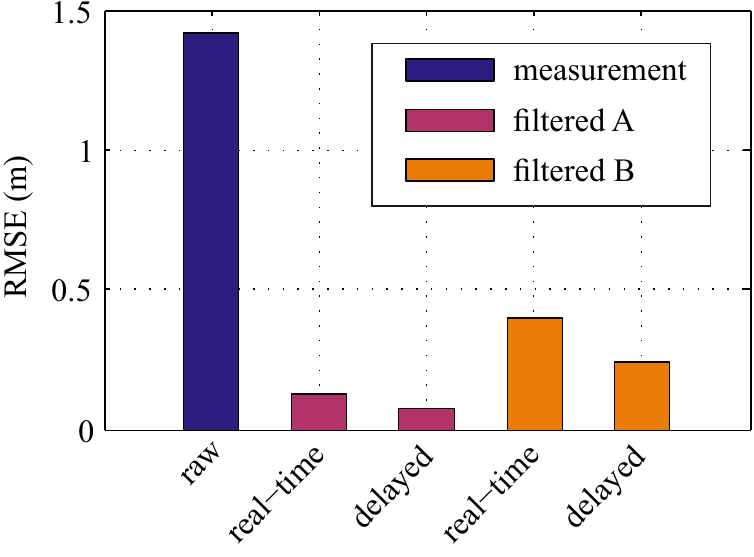
Figure 7. RMSE for filtering real data. The RMSE with respect to the RTK-GPS reference data adds up to 1.42 m for the raw measurements, 0.13 m for the filtered positions (no lag) according to Method A and 0.40 m for Method B . Using delayed filtering with a constant lag of 500 ms, the RMSE was reduced to 0.07 m for Method A and to 0.24 m for Method B